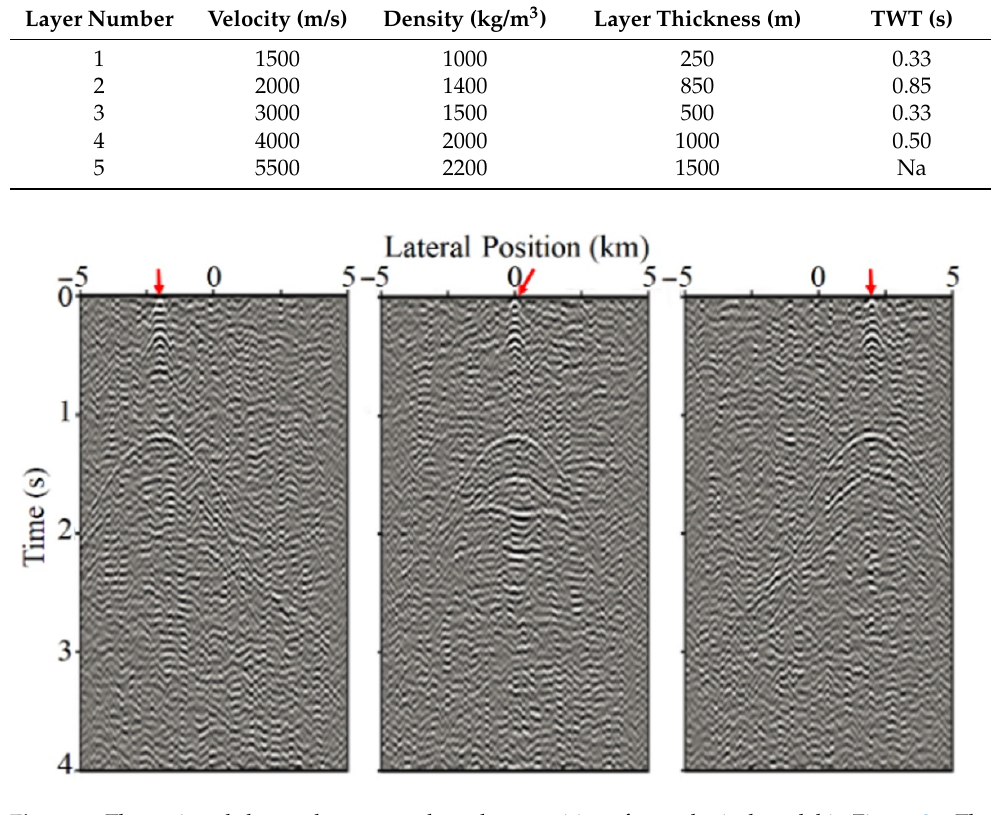
Figure 4. Three virtual shot gathers example at three positions for geological model in Figure 3a. The red arrows show the location of the master trace.